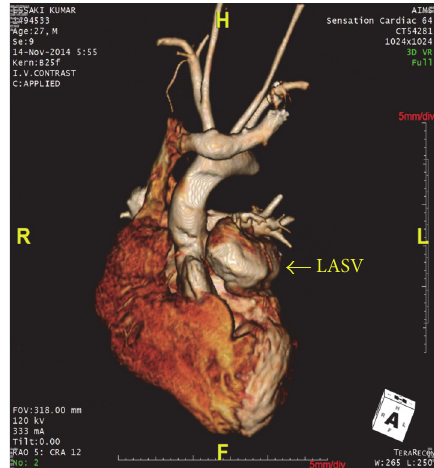
Figure 7: A 3D reconstructed MDCT chest coronal section image indicating left aneurysm of sinus of Valsalva